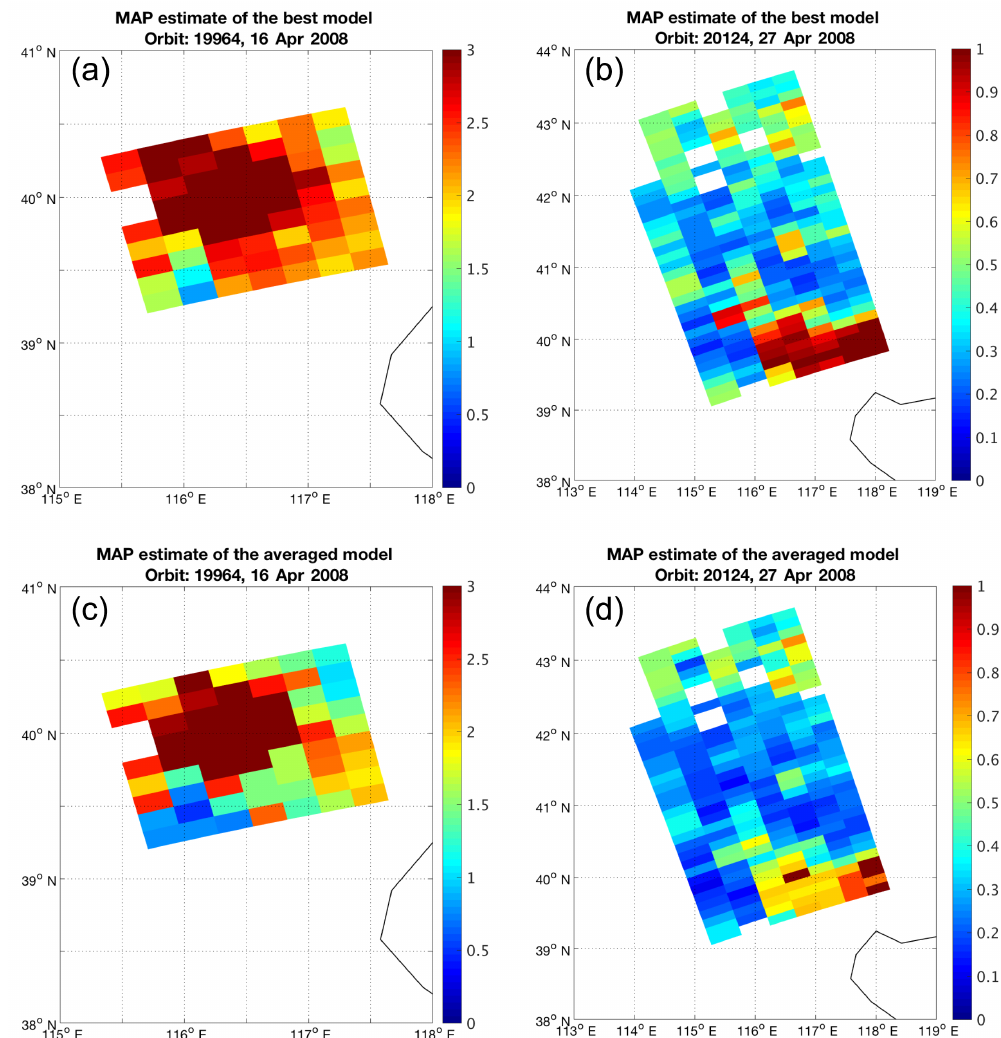
Figure 6. The MAP AOD estimate based on the best model (a, b) and based on the averaged posterior distribution (c, d) shown for 16 April (a, c) and 27 April (b, d) . Please note the different colour